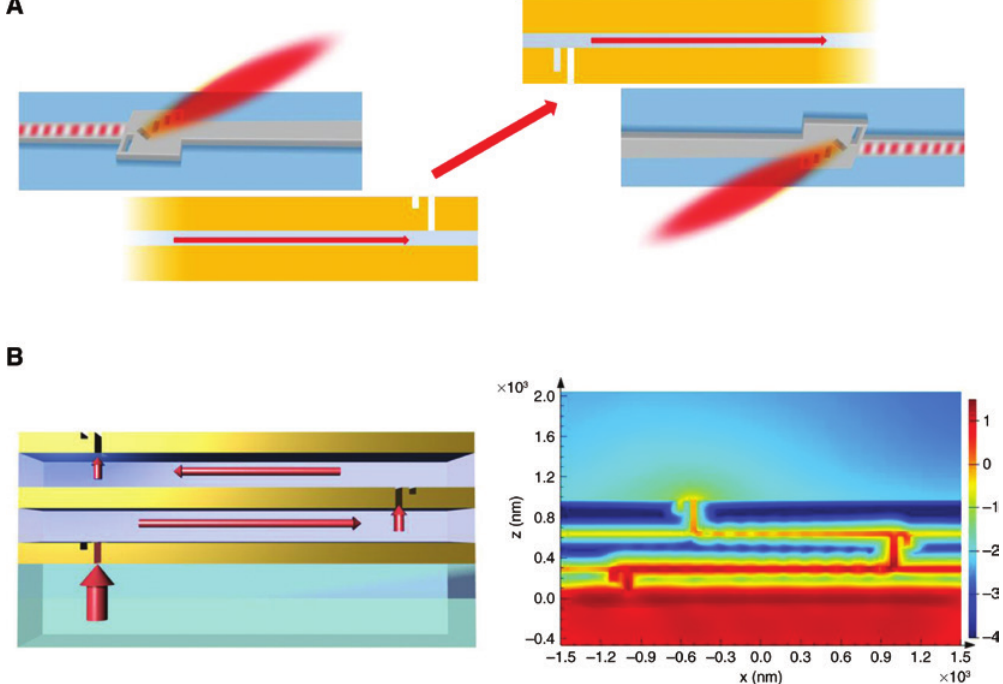
Figure 13: Optical interconnections using optical slot antennas. (A) Schematics of optical interconnection using optical slot antennas integrated to MIM plasmonic waveguide and (B) schematics of plasmonic via in multilayered structure with stacked MIM plasmonic waveguides: (left) 2D-FDTD simulation result showing directional coupling in a multilayered structure